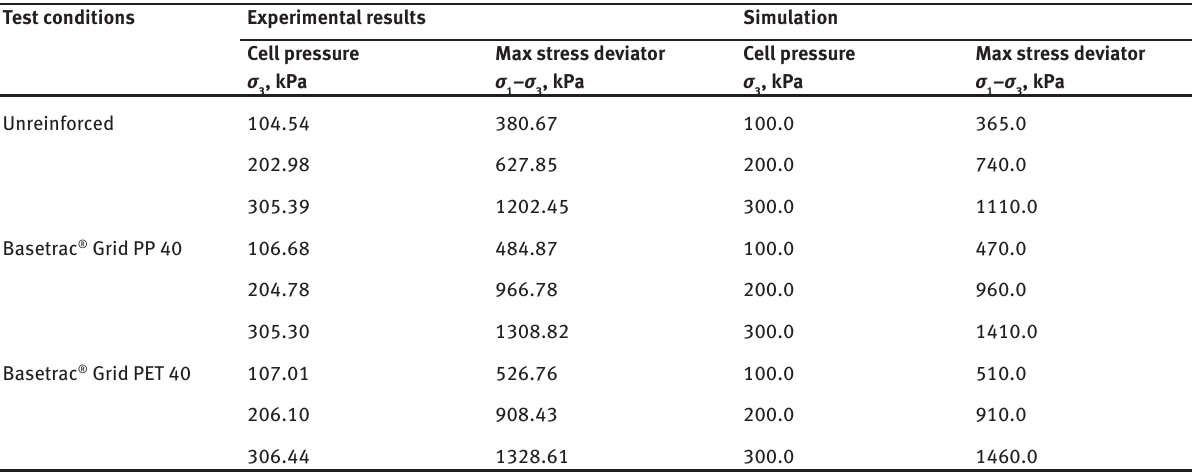
Table 4: Simulated unreinforced and reinforced soil shearing strength with PLAXIS 3D. Test